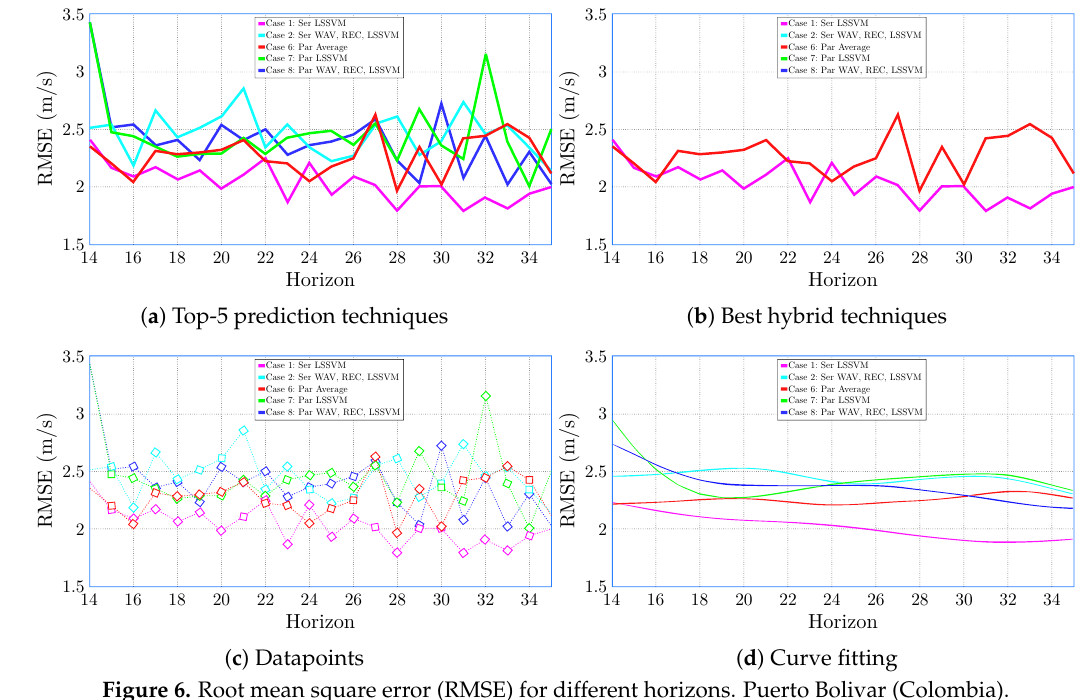
Figure 6. Root mean square error (RMSE) for different horizons. Puerto Bolivar